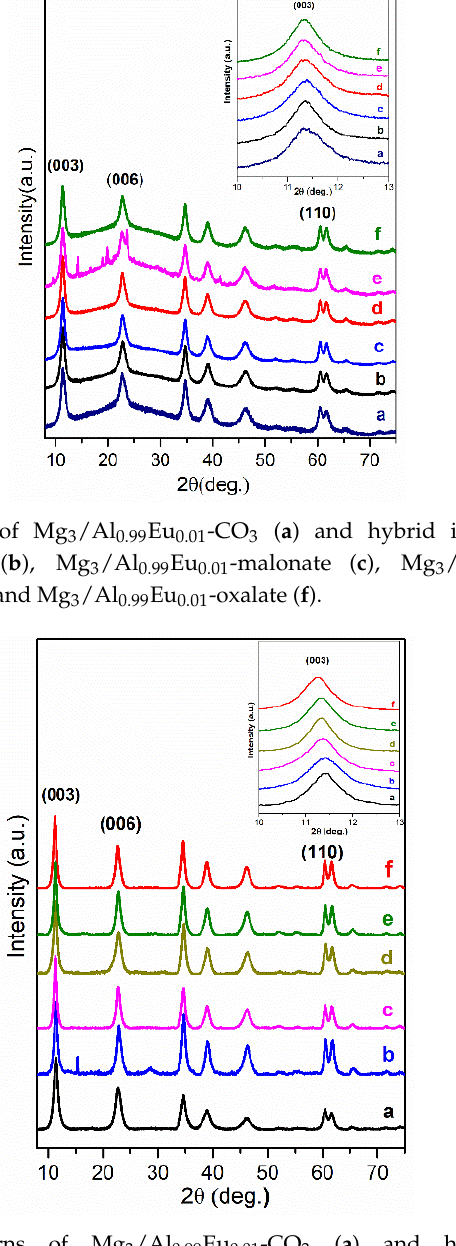
Figure 5. XRD patterns of Mg 3 /Al 0.99 Eu 0.01 -CO 3 ( a ) and hybrid inorganic-organic LDHs: Mg 3 /Al 0.99 Eu 0.01 -4-dimethylaminobenzoate ( b ), Mg 3 /Al 0.99 Eu 0.01 -4-methylbenzoate ( c ), Mg 3 /Al 0.99 Eu 0.01 -1,3,5-benzentricarboxylate ( d ), Mg 3 /Al 0.99 Eu 0.01 -benzoate ( e ) and Mg 3 /Al 0.99 Eu 0.01 -4-biphenylacetonate ( f ). FT-IR spectra of Mg 3 /Al, Mg 3 /Al 0.99 Eu 0.01 and hybrid inorganic-organic LDHs are shown in